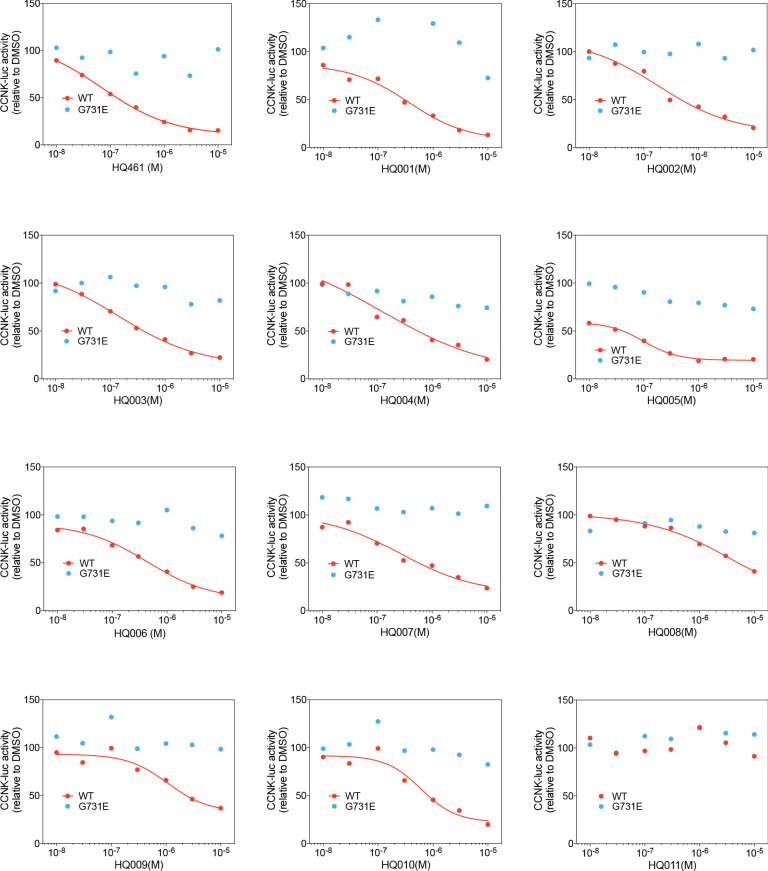
Dose response curves of HQ461 analogs in reducing CCNK-luc activity.The CCNK-luc reporter co-transfected with CDK12KD with the G731E mutation verifies that CCNK-luc degradation is on-target.